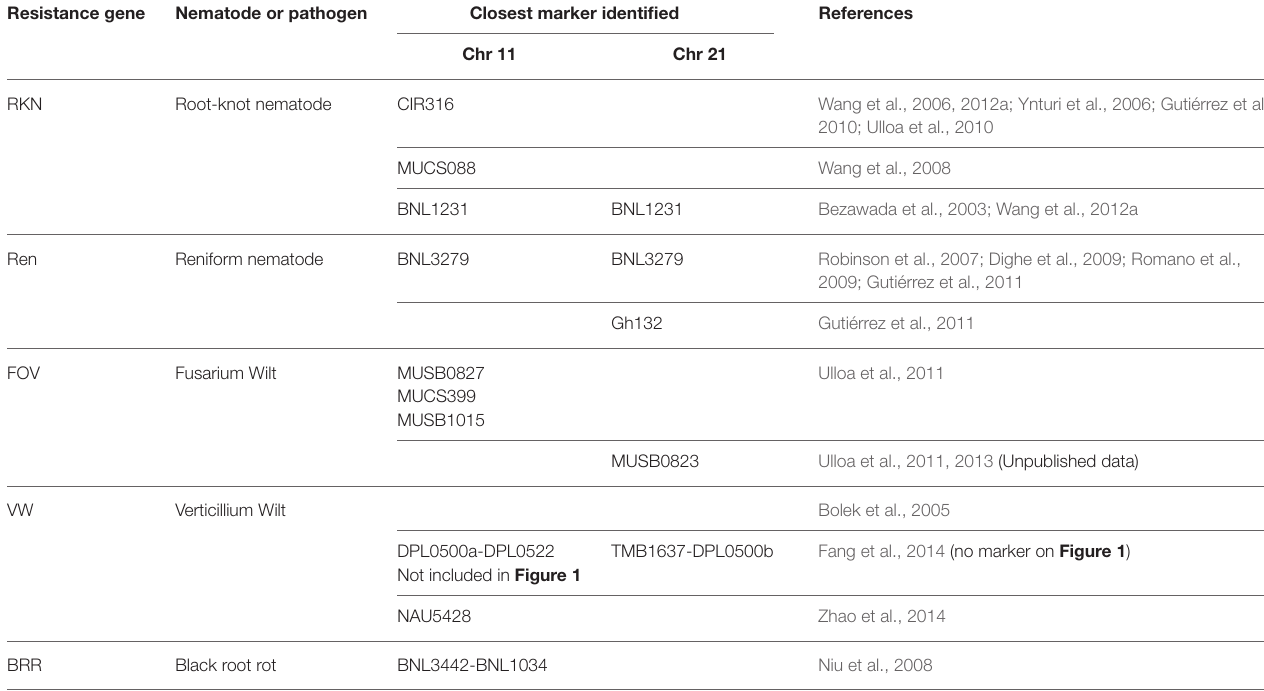
TABLE 2 | SSR markers underlying QTL associations with nematode and pathogen resistance genes on Upland cotton chromosomes 11 and 21. Resistance